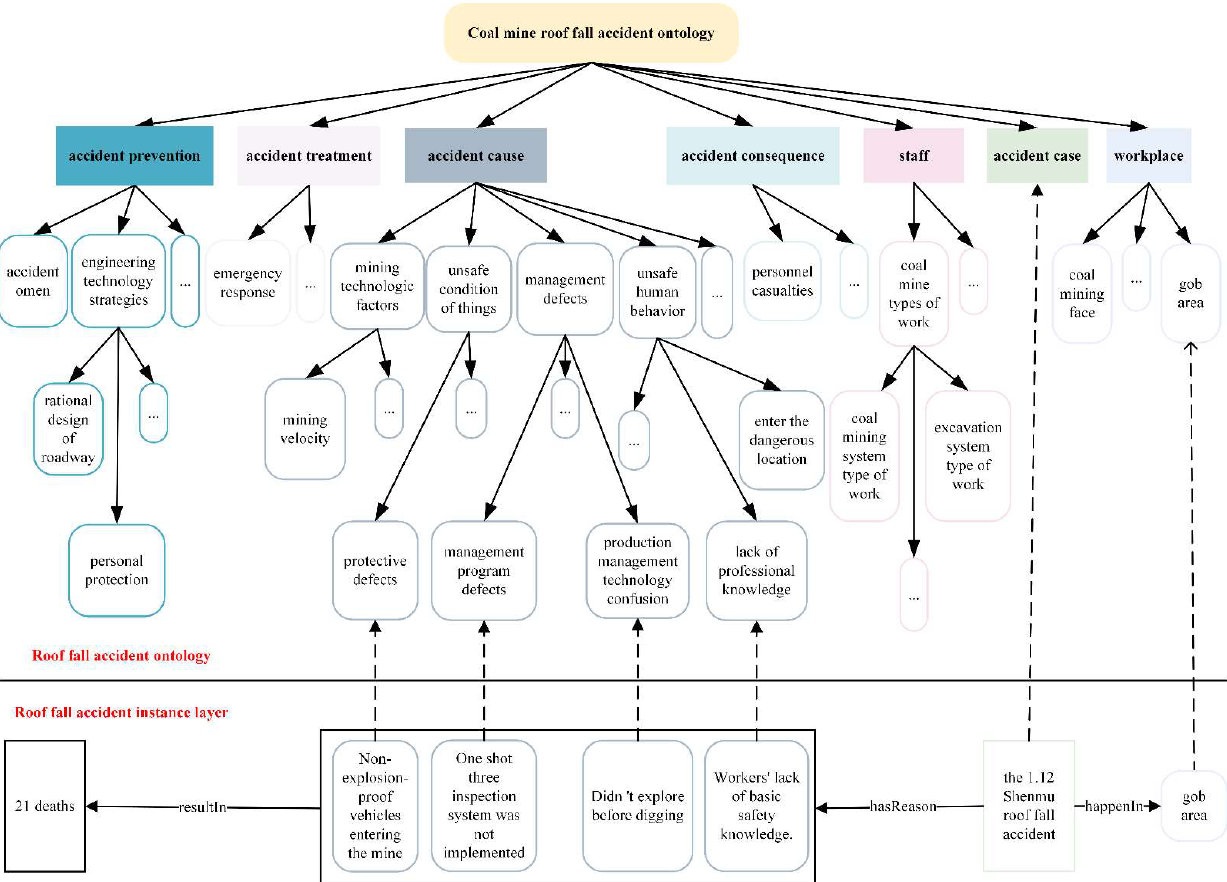
Figure 6. An integrated framework for mapping roof fall accident instances to ontology.